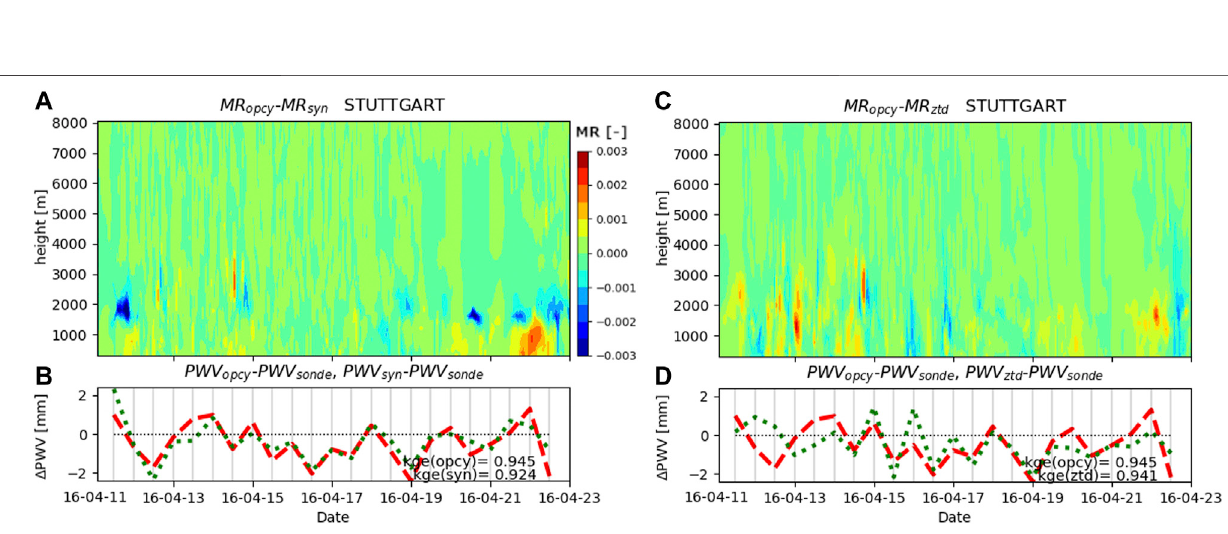
Frontiers in Earth Science |